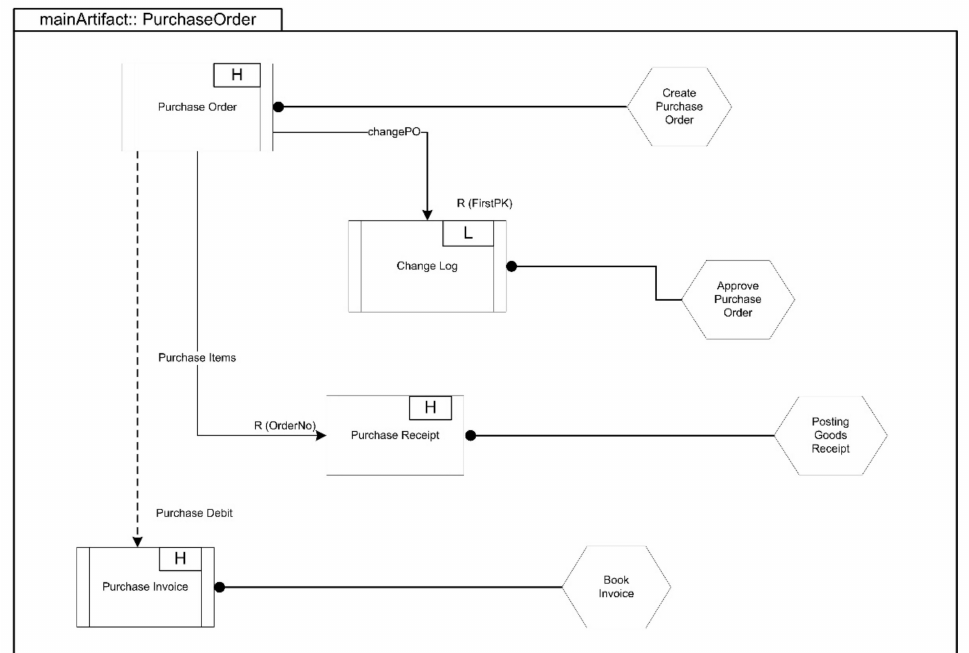
Figure 5. DSML purchase model for event log